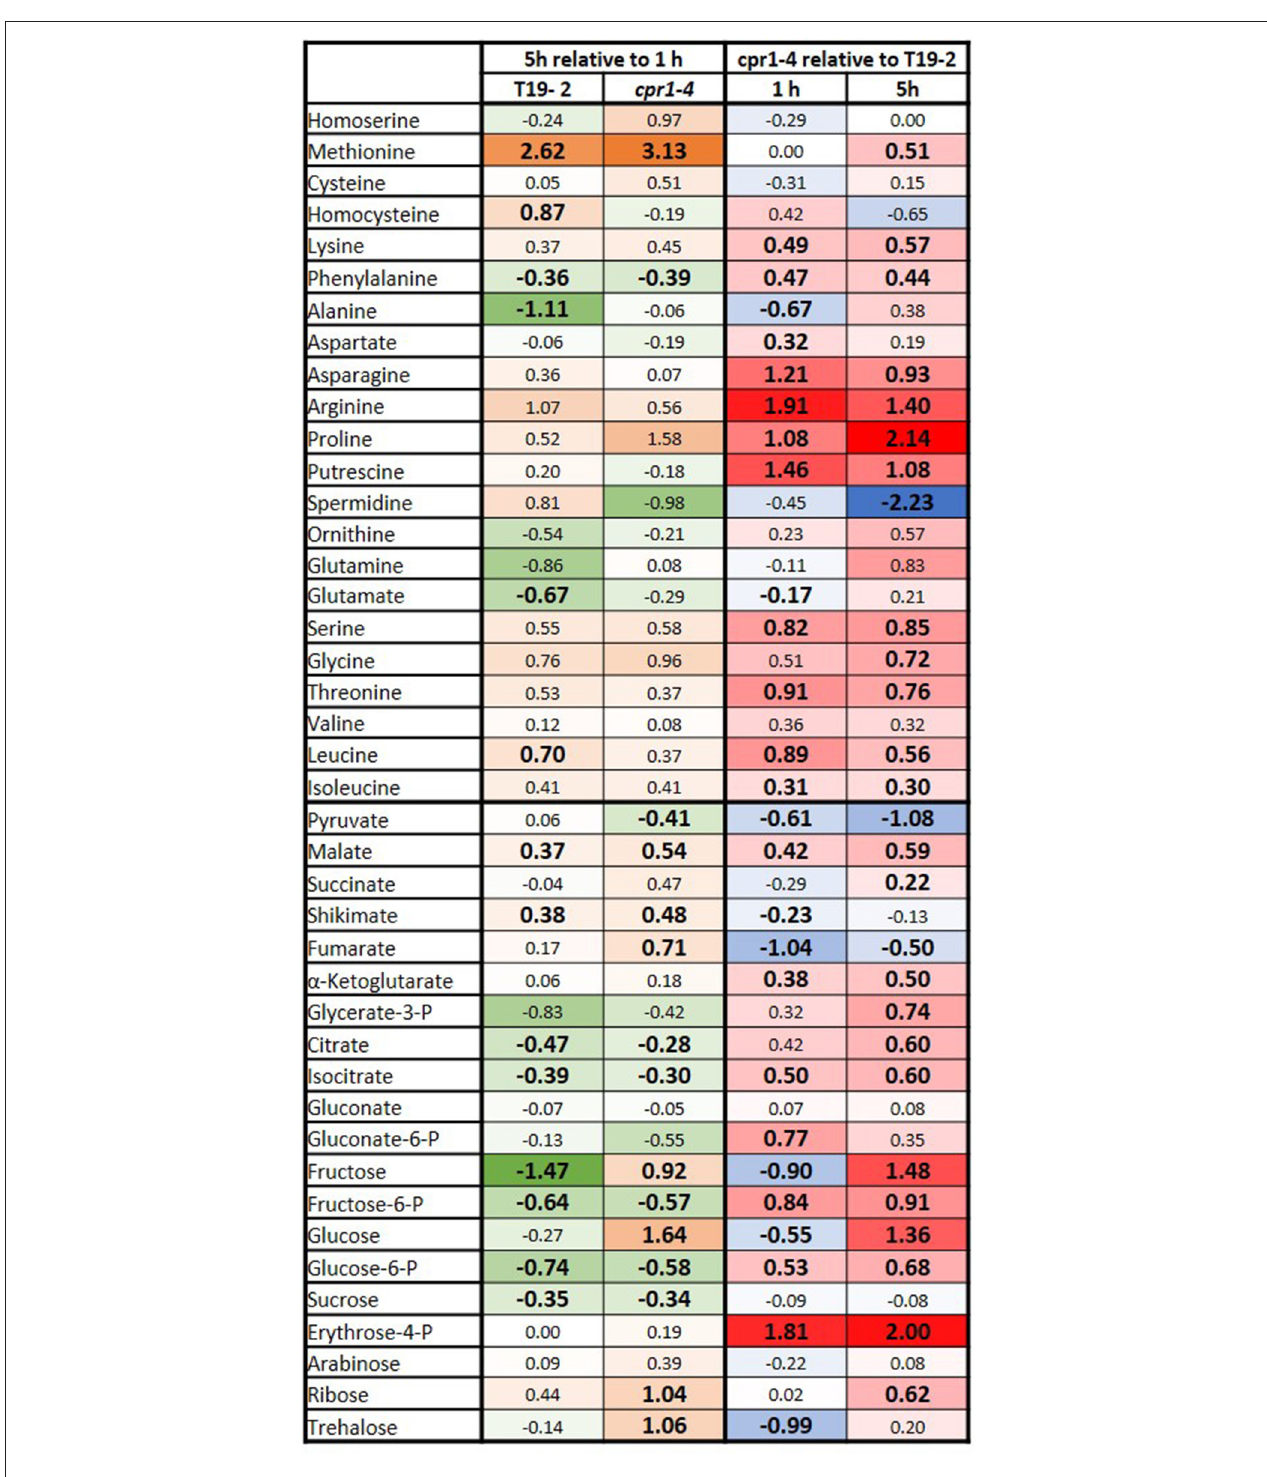
FIGURE 4 | Heat-map depicting the log 2 of the relative changes in carbohydrate and amino acid contents as determined by GC-MS in 4-week-old, soil-grown cpr1-4 and T19-2. Left: The relative change between 5 and 1 h illumination in T19-2 and cpr1-4 . The strongest decrease is presented in dark green (negative numbers), the strongest increase in orange (positive numbers). Right: The metabolite level in cpr1-4 relative to T19-2. The highest relative level is shown in bright red (positive numbers), the lowest in blue (negative numbers). Unchanged metabolites are marked in white. Statistically significant regulation is presented in bold and slightly larger than the other numbers ( n = 3 biological replicates; pairwise t -test, P < 0.1).